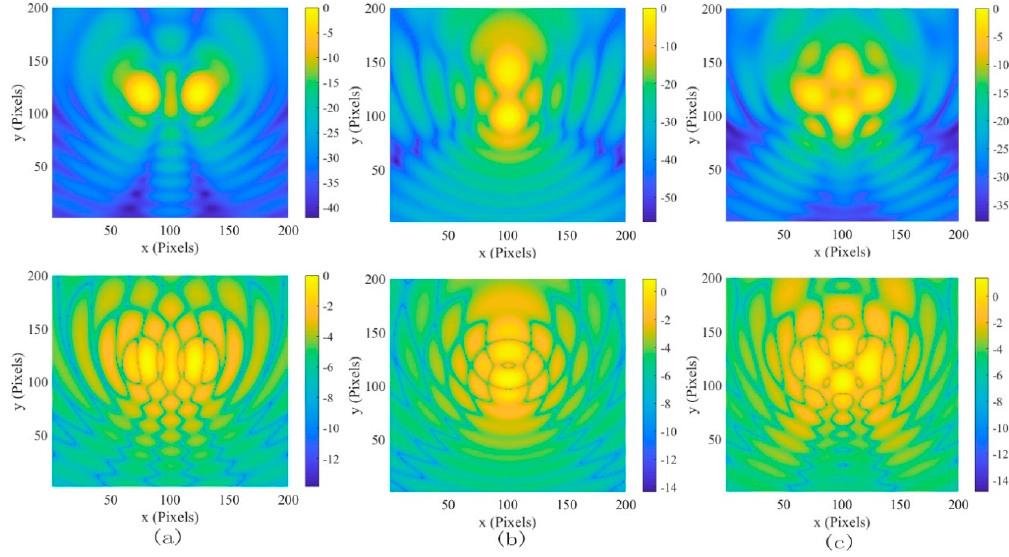
Figure 2. The images of coherent interference sources and the distribution of the logarithm of the coherent noise intensity in the images at 2 GHz. ( a ) Two coherent electromagnetic interference sources (EMIS) placed horizontally, ( b ) two coherent EMIS placed vertically, and ( c ) four coherent EMIS.